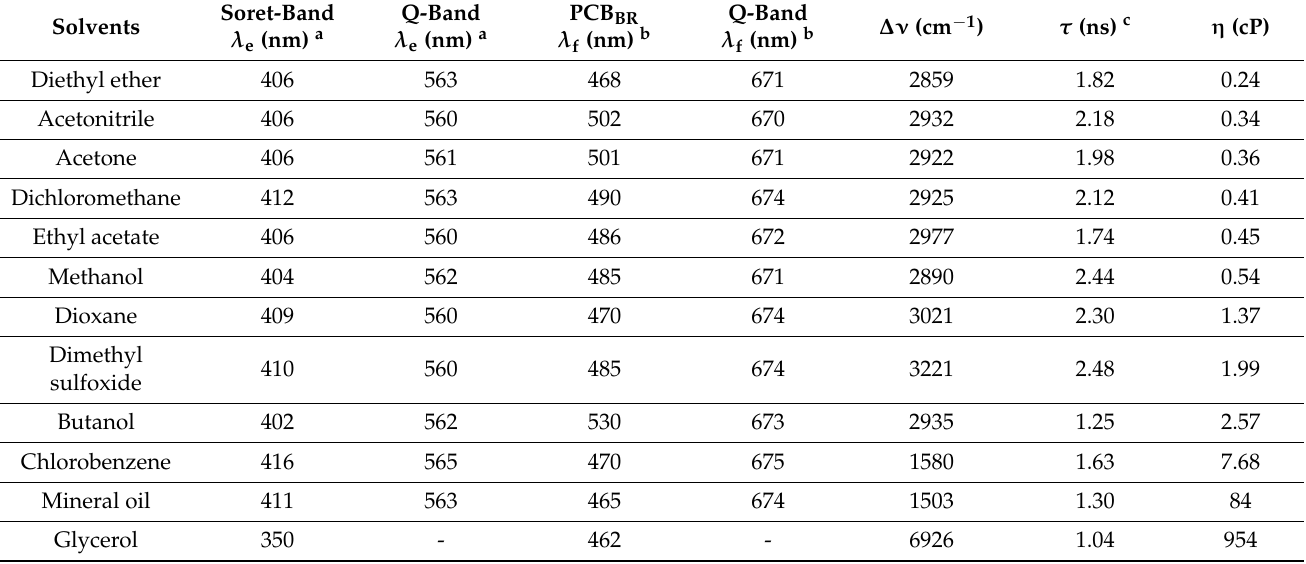
Table 1. PLE ( λ e ) and PL ( λ f ) peak positions, average excited-state lifetimes ( τ ), and stokes shifts ( ∆ ν